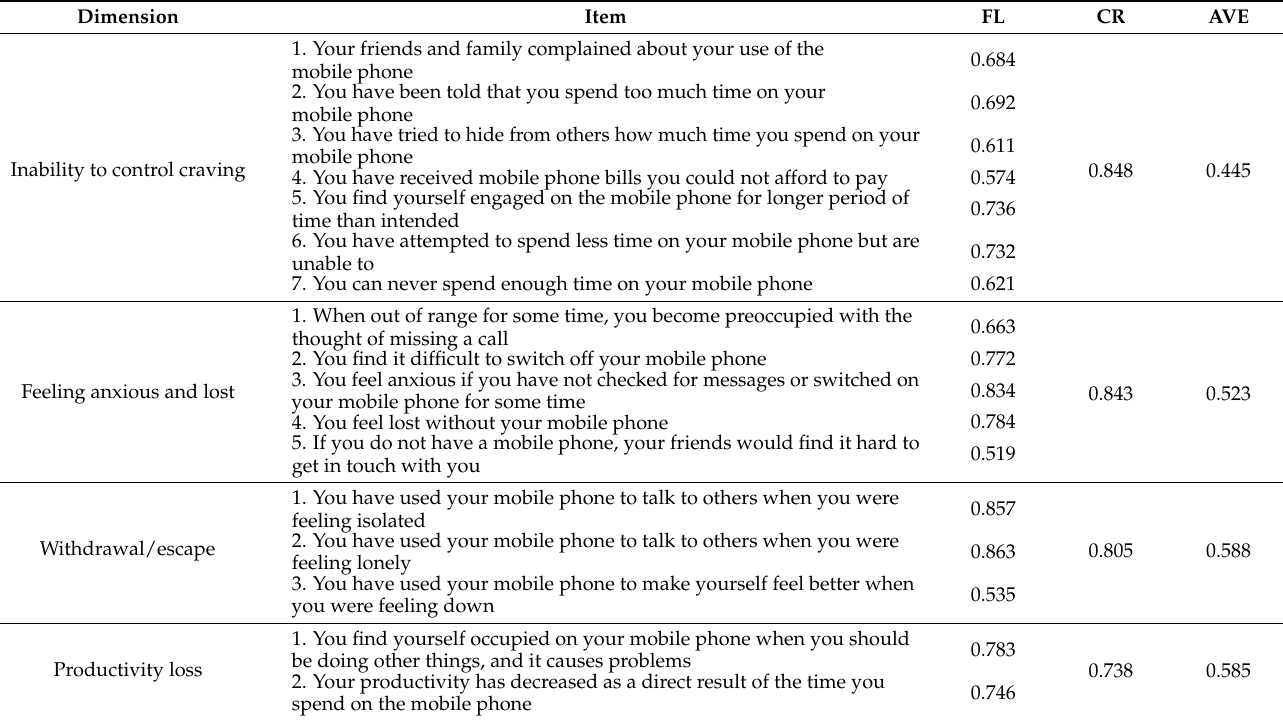
Table 2. Confirmatory factor analysis of the mobile phone addiction